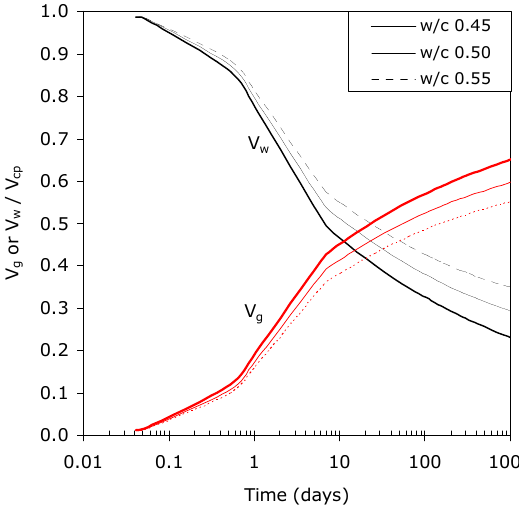
Figure 4. Volumetric fraction of gas and capillary water in pore system.